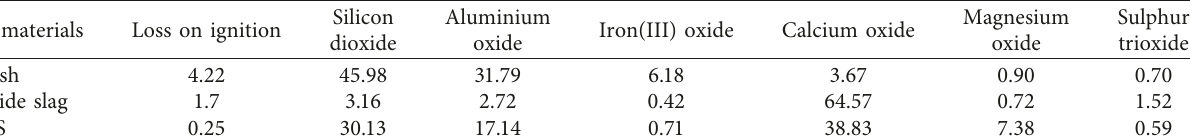
Table 1: Chemical compositions of raw materials (in wt.%).